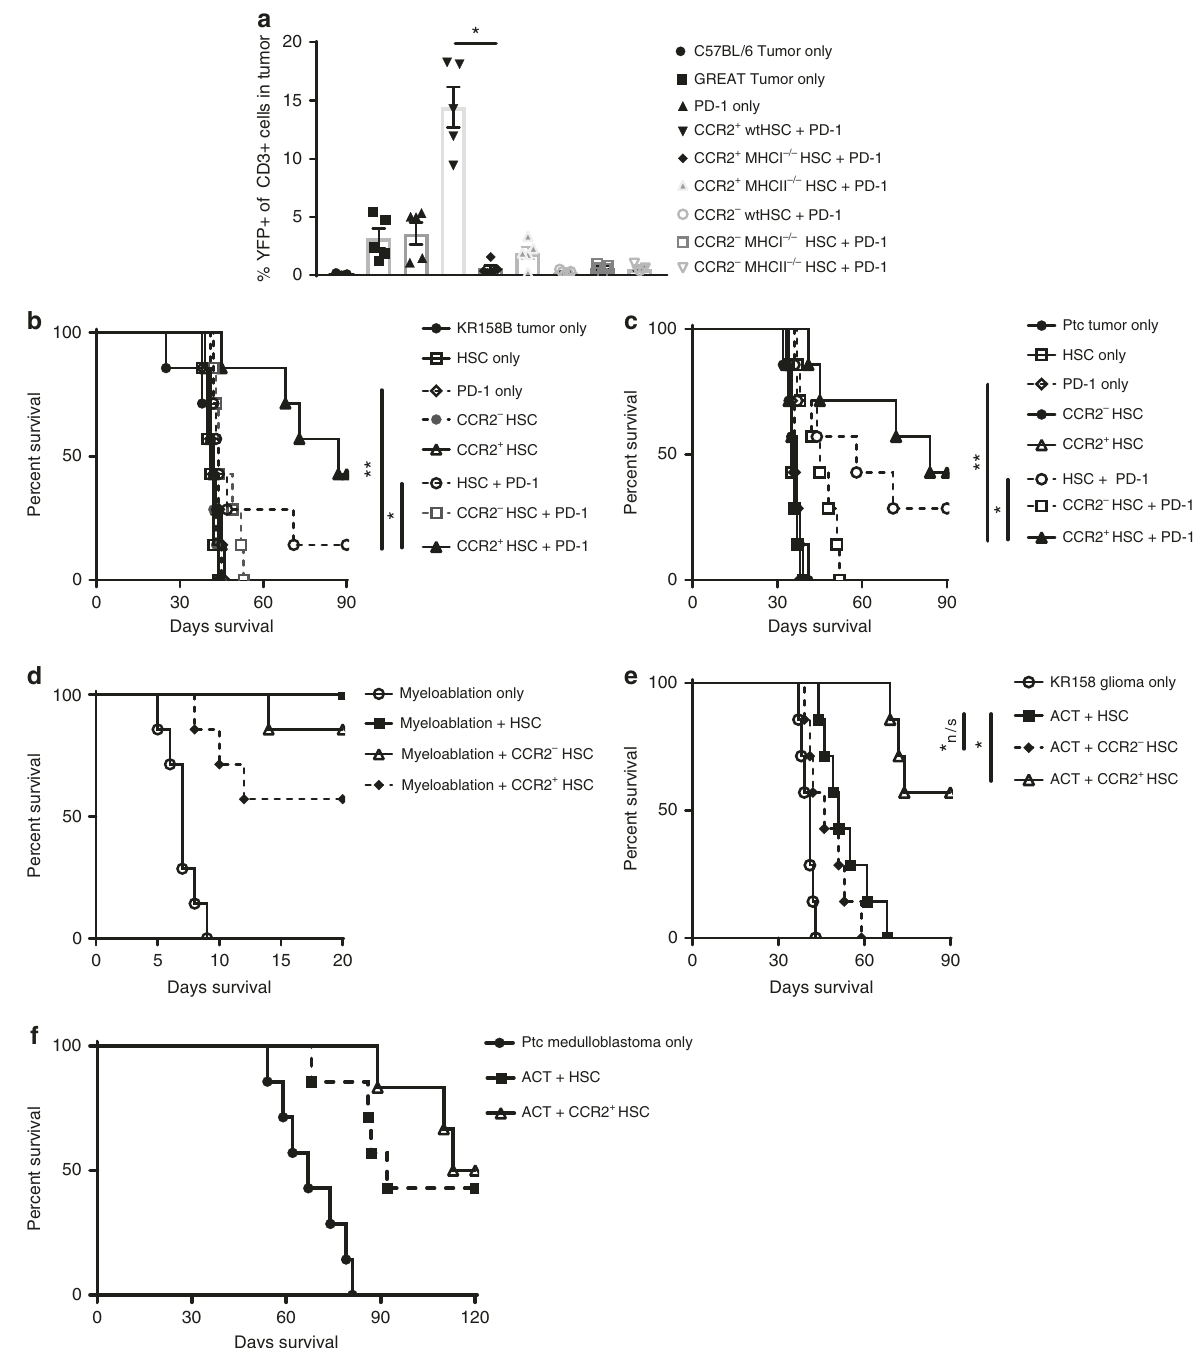
Fig. 8 CCR2 + HSCs increase ef fi cacy of PD-1 against brain tumors. a KR158B tumor-bearing GREAT mice were treated with PD-1 and either CCR2 − HSCs